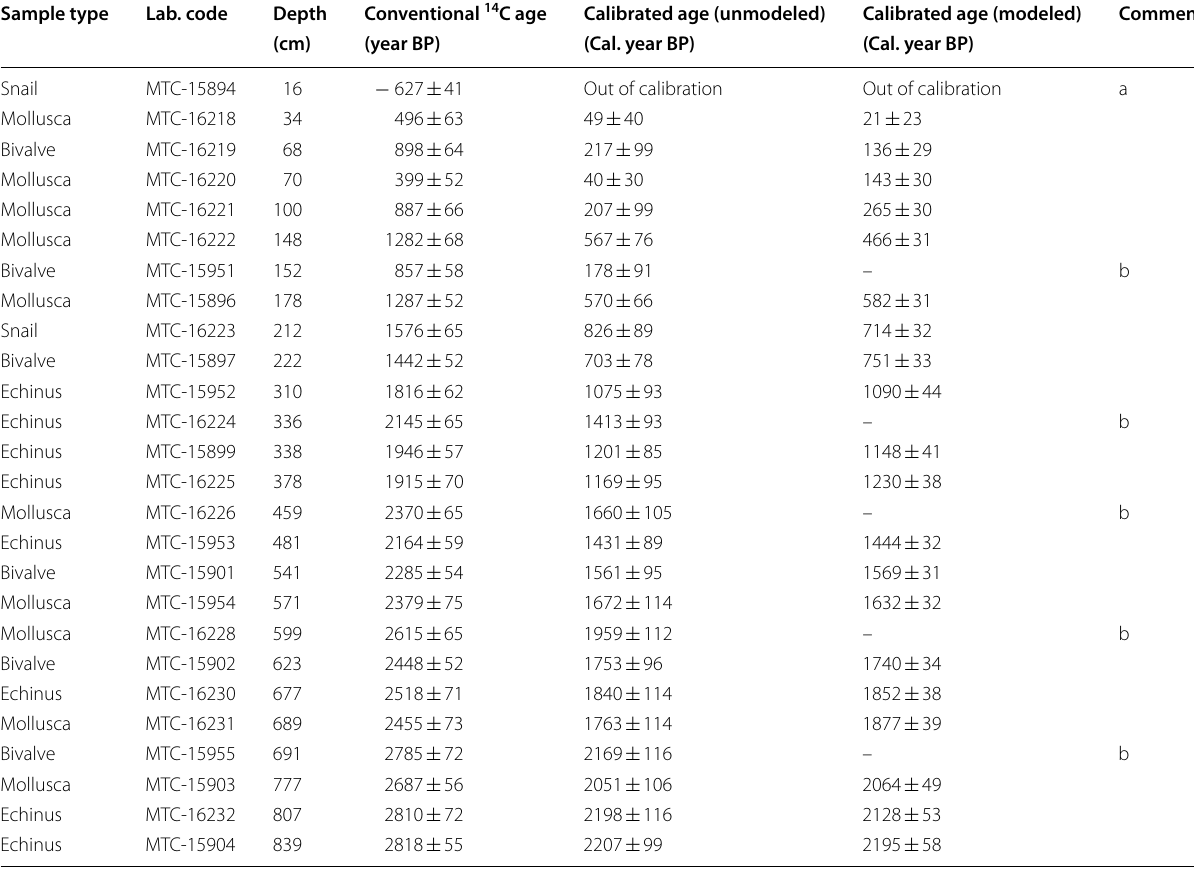
Table 2 Depth and radiocarbon-derived dates ( ages defines a 68.2% confidence